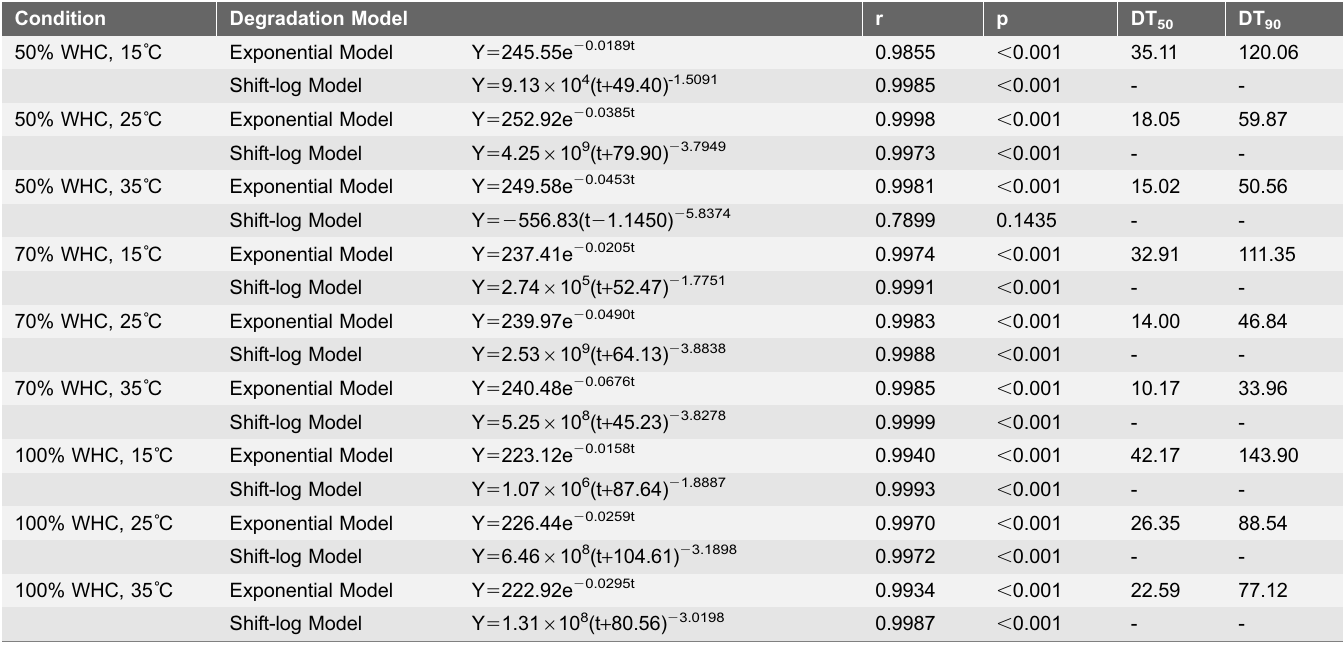
Table 4. Degradation model, DT 50 and DT 90 of Cry1Ac protein in buds in the